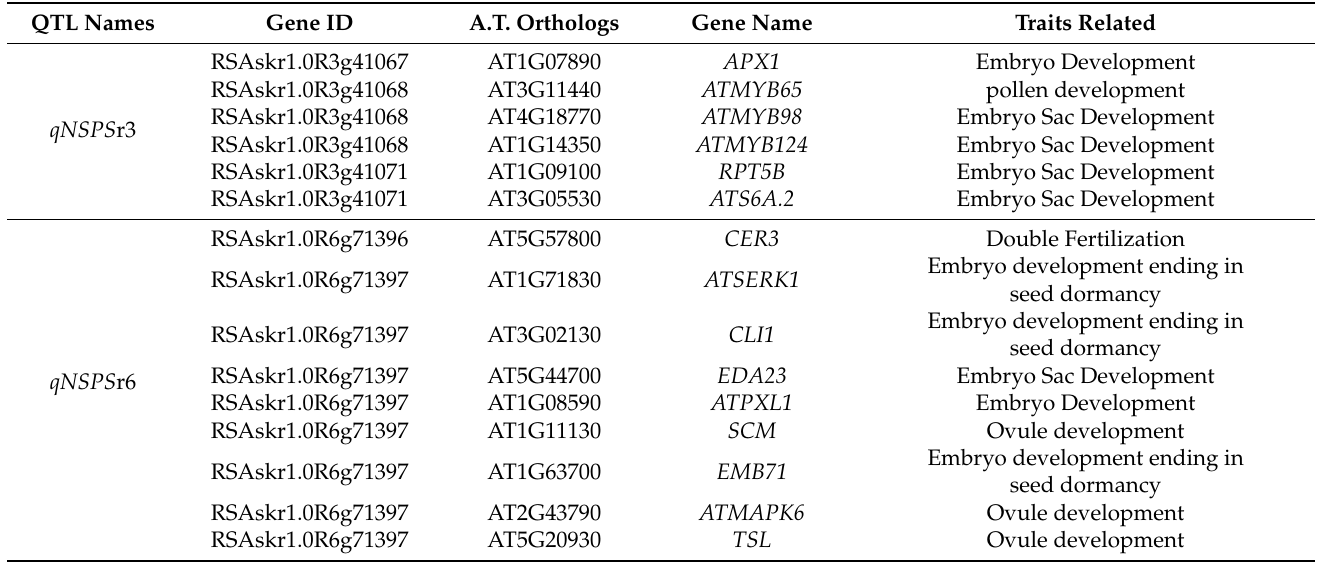
Table 3. The list of Arabidopsis orthologs related to the two QTL regions for the number of seeds per silique in radish. Traits related to genes were based on Yang et al., 2019